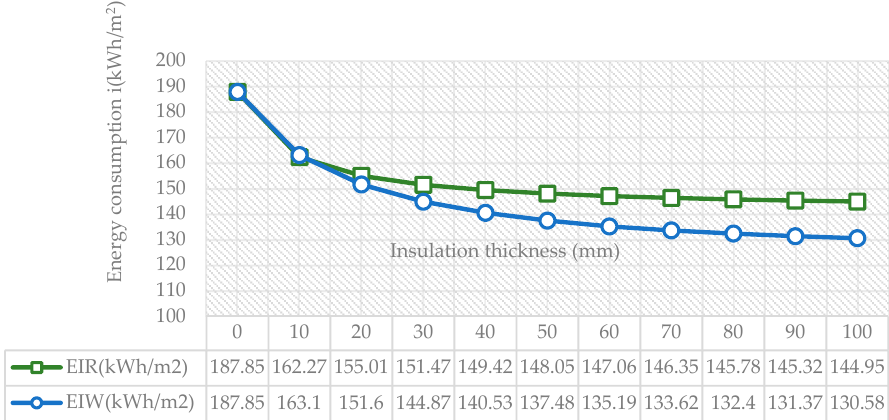
Figure 13. Energy consumption for insulation materials (XPS) of different thickness (kWh/m 2 ). EIR = 177.469 − 7.317 × ln(N), N = 10, 20, 30, . . . , 90, 100; R 2 = 0.969, (1) where EIR is the energy consumption in the case of the insulation roof (kWh/m 2 ) and N is the insulation thickness of XPS.